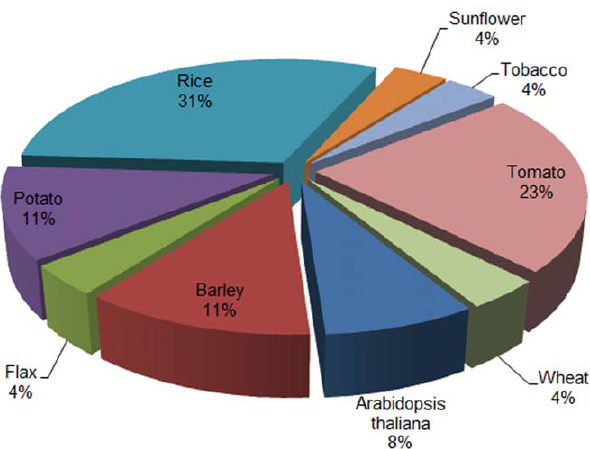
Figure 2. The distribution of zinc finger domains across different crops. The cloned R genes of various crops were found to have zinc finger domain in their proteins. The number of zinc finger domains represented by cloned R genes of each crop is shown in pie chart.